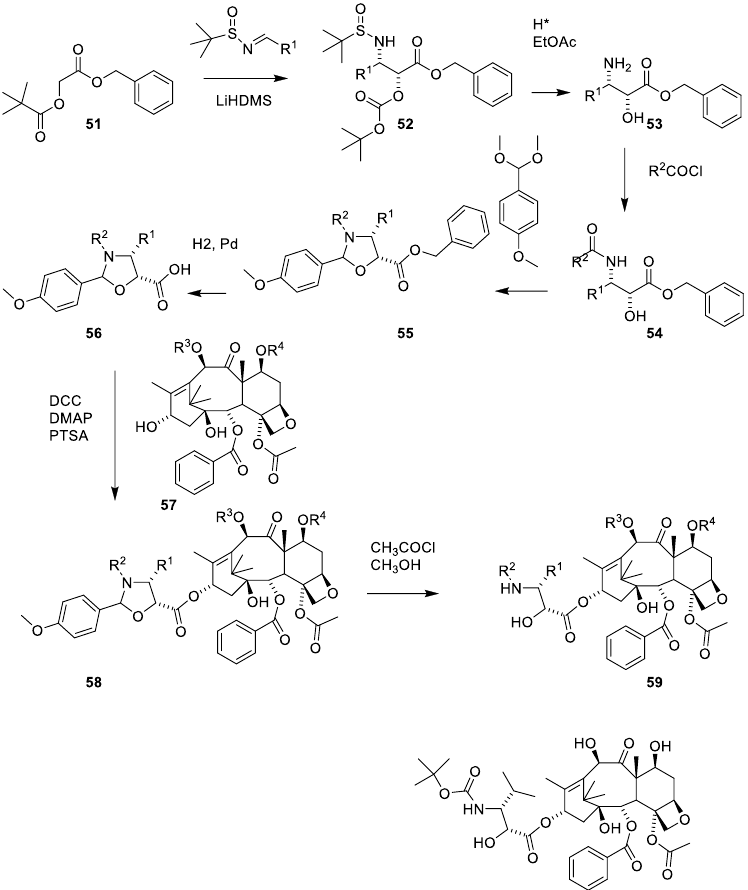
Figure 14. Preparation and use of oxazolidine-5-carboxylic acid ( 56 ) for esterifying O-13 of masked deacetylbaccatin III ( 57 ) [59]. LiHDMS: lithium hexamethyldisilazide, DCC: dicyclohexylcarbodiimide, DMAP: 4-dimethylaminopyridine, PTSA: paratoluenesulfonic acid [59].